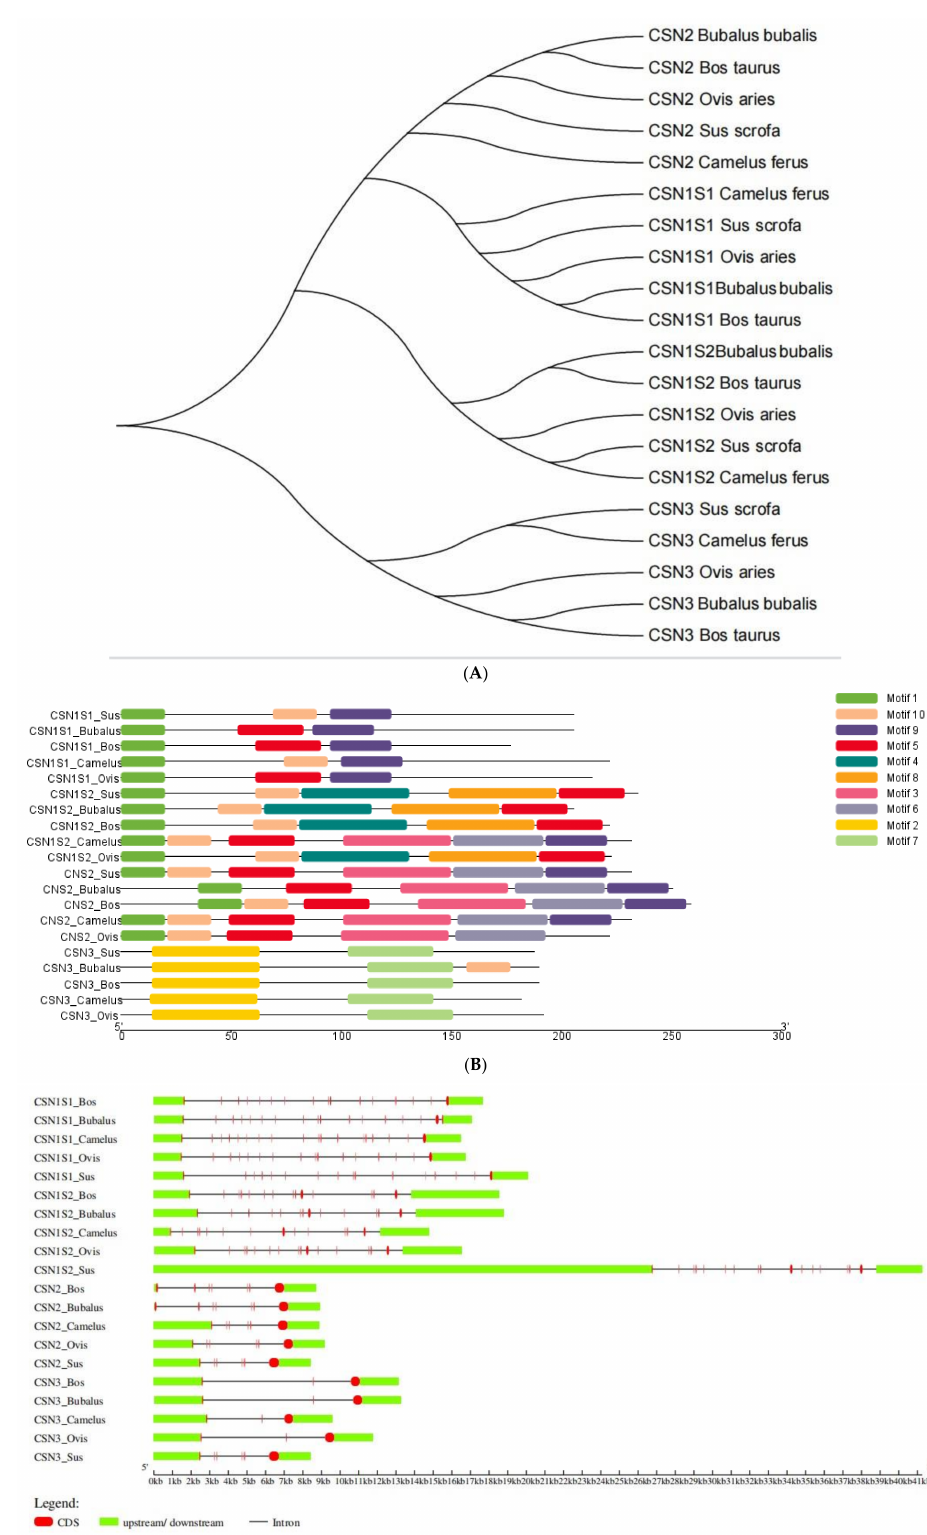
Figure 2. Genome structure, motif patterns, and conserved regions of the casein protein gene family phylogenetic connections. ( A ) The phylogenetic connection of the 20 amino acid sequences of casein proteins. ( B ) A recurring motif. In the casein gene family, there are many structural variants ( C ). Color- coded boxes denote ten distinct themes. Table 1 provides further information about the